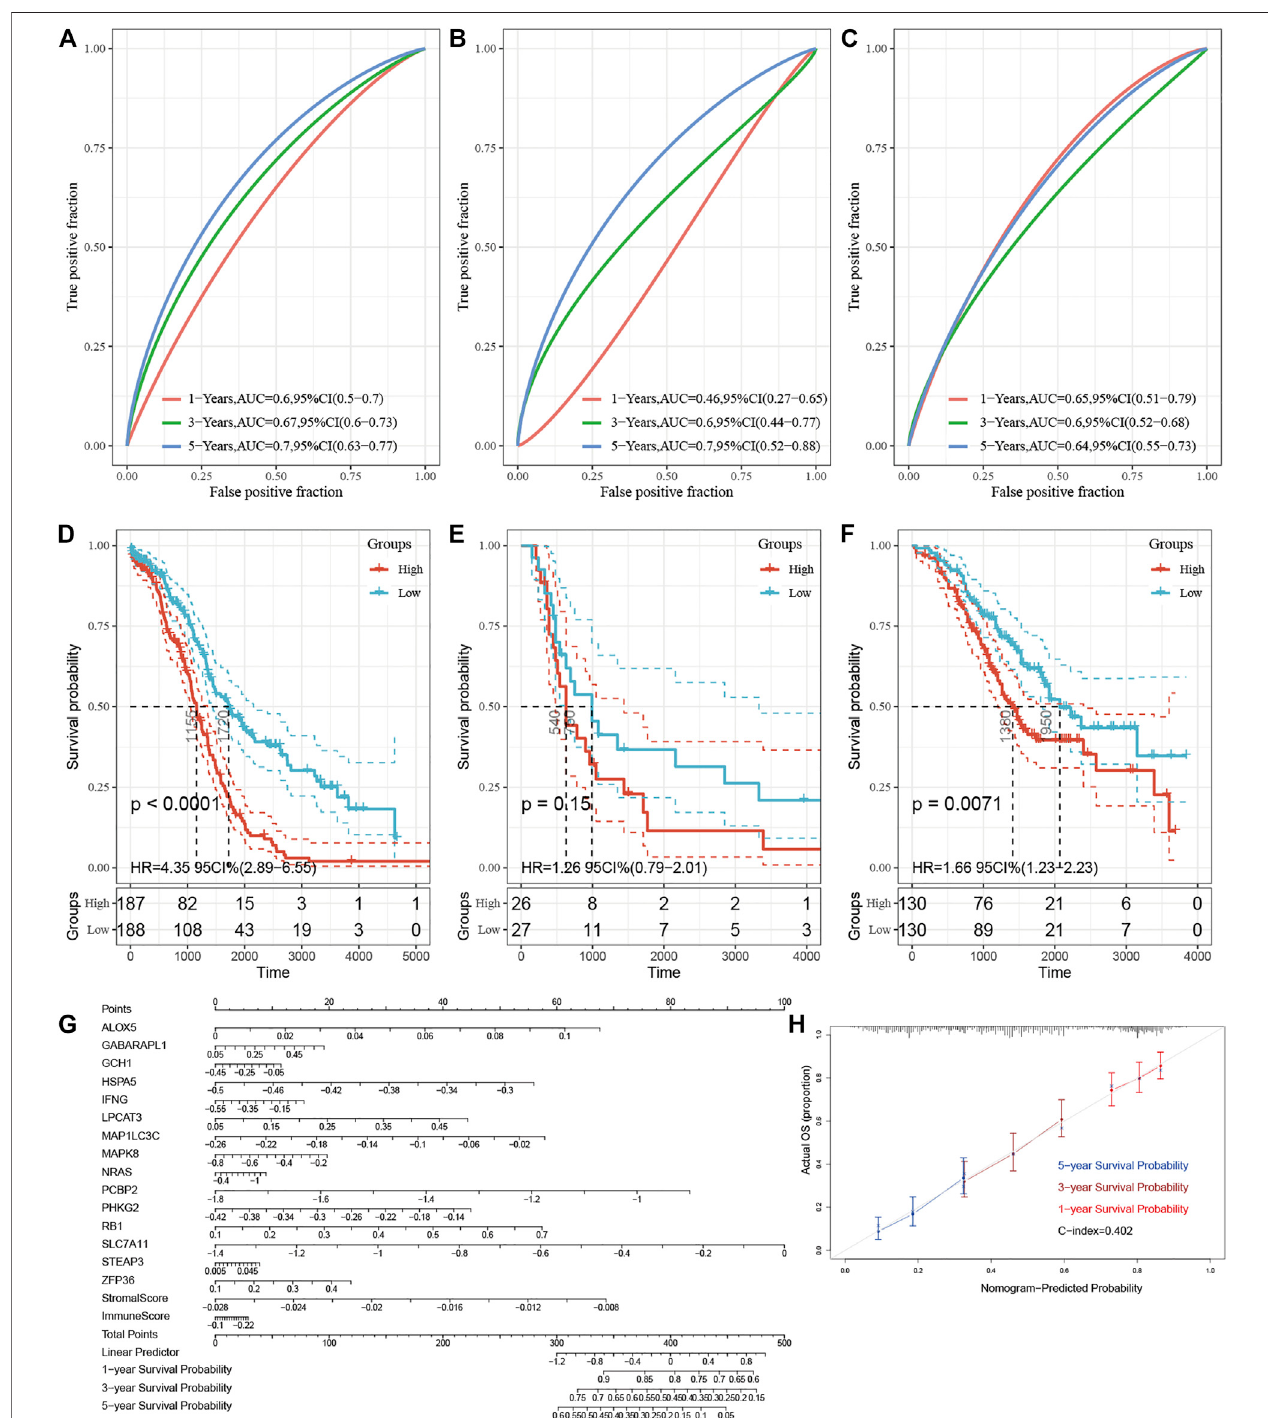
FIGURE 7 | Validation of the E-FRG model and development of a nomogram for improving the model. (A – C) Area under the curve of the ROC curve is used to visuallyindicatethepredictivepowerofE-FRGscoresfor1-,3-,and5-yearOSofOCpatientsintheTCGAdataset (A) ,GSE18520 (B) ,andGSE32062 (C) ,respectively. (D – F) Kaplan – Meier curves for 1-, 3-, and 5-year OS with low and high E-FRG scores in the TCGA dataset (D ), GSE18520 (E) , and GSE32062 (F) , respectively. (G) Nomogram for predicting the 1-, 3-, and 5-year OS probabilities of OC patients. The total score is composed of 17 scoring features. Each score of the nomogram corresponds to the genes or ESTIMATE scores in the E-FRG model. (H) Calibration of the nomogram for predicting the probability of survival at 1-, 3-, and 5-year in TCGA (C-dex (cid:1) 0.402).